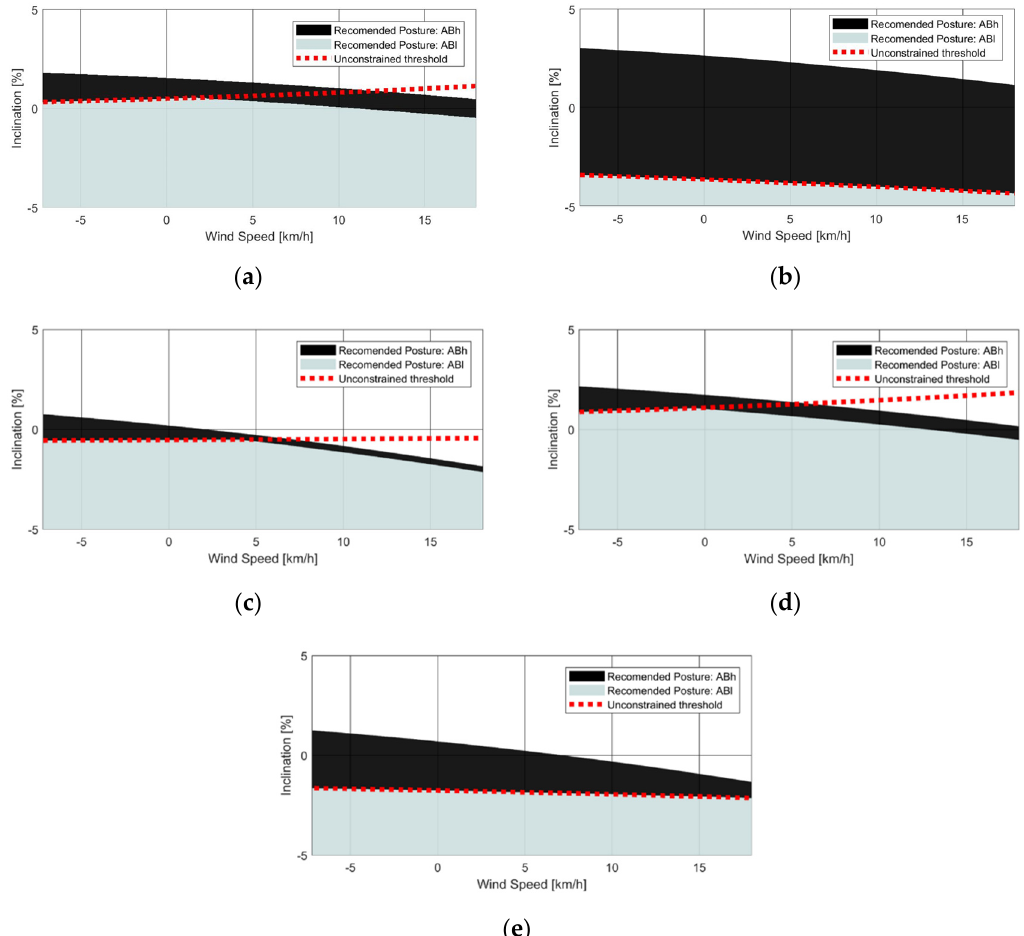
Figure 7. Posture selection results for the tested cyclists and bicycles. ( a ) Rider 1; ( b ) Rider 2; ( c ) Rider 3; ( d ) Rider 4; ( e ) Rider 5. The comparison of the posture threshold line due to race time only (red dotted line) with the zones of posture selection (light and dark color areas) shows that only for some cyclists the dotted line corresponds with the change between the postures (i.e., Riders 2 and 5). A difference between